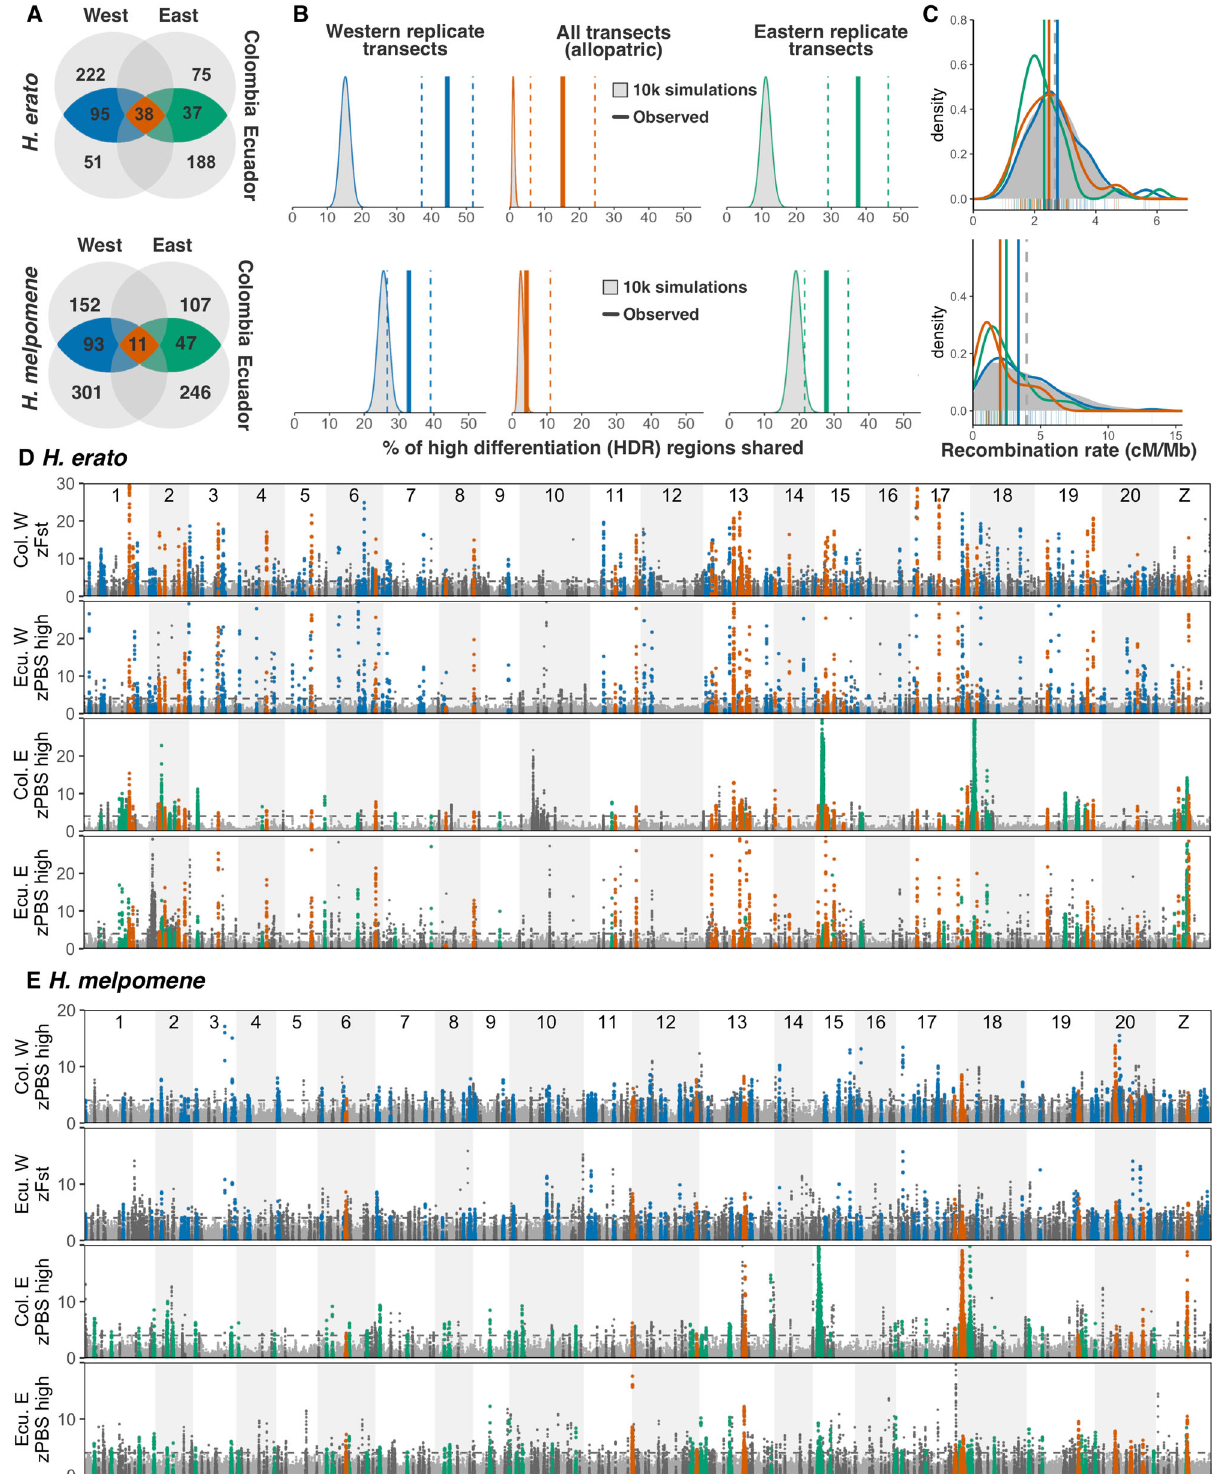
Fig. 3 | Molecular parallelism in PBS/F st regions of differentiation across eight altitude transects of H. erato and H. melpomene. A Number of high- differentiation regions per species (HDRs, including ± 50kb buffers), in blue/green if shared across replicate transects within sides of the Andes (SHDR: blue=within West, green=within East) and in red those additionally shared across allopatric transects,i.e.sharedacrossallfourtransects(alsoSHDR).Sourcedataareprovided in the Source Data fi le. B Vertical lines represent percentage of outlier windows sharedacrosstransects(jackkniferesamplingcon fi denceintervalsasdashedlines),